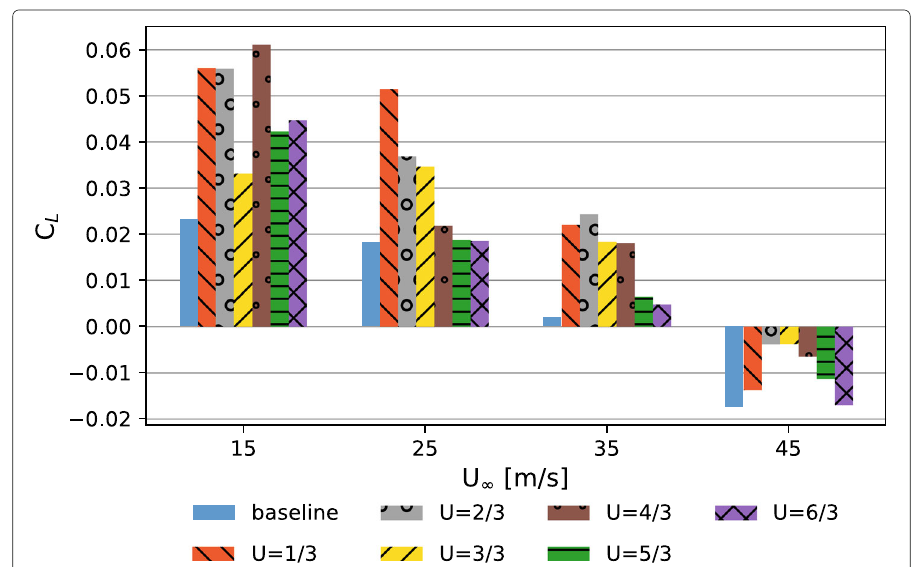
Fig. 22 Time-averaged lift coefficient for the notchback DrivAer model with 45 ◦ air-jet wheel